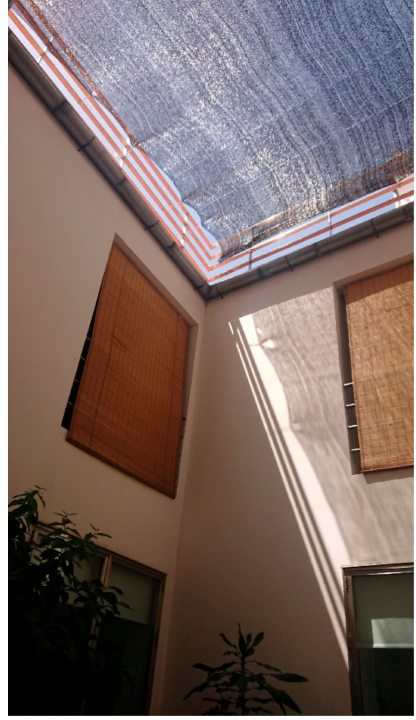
Figure 1. Image of the analyzed courtyard with the shading device displayed.